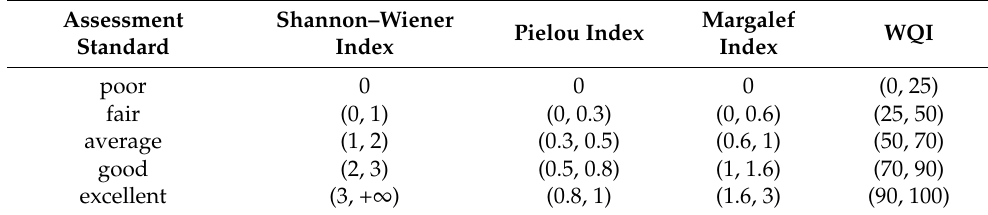
Table 2. Assessment standard of diversity